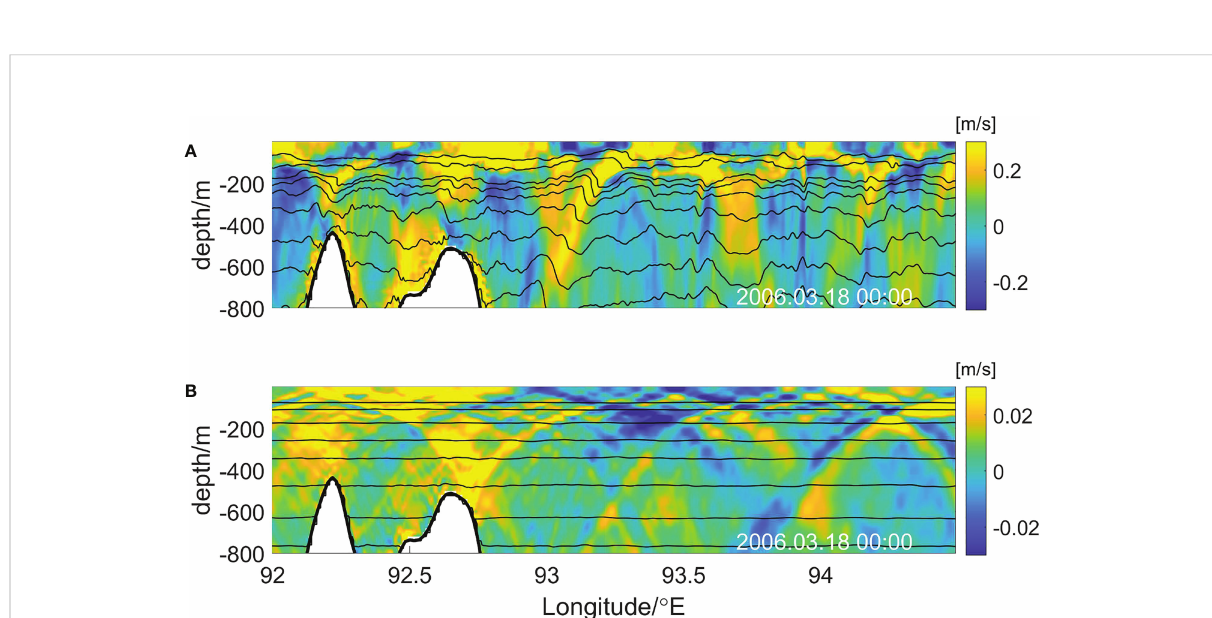
FIGURE 7 Selected section along 10.27°N (see the red line in Figure 1) of (A) semidiurnal internal tides and (B) diurnal internal tides showing modelled zonal baroclinic velocity (u ′ , colour coded in m/s on the right-hand side) dated 18 March 2006 at 00:00. The solid black lines are isotherms. Note that the color scales in the two panels are